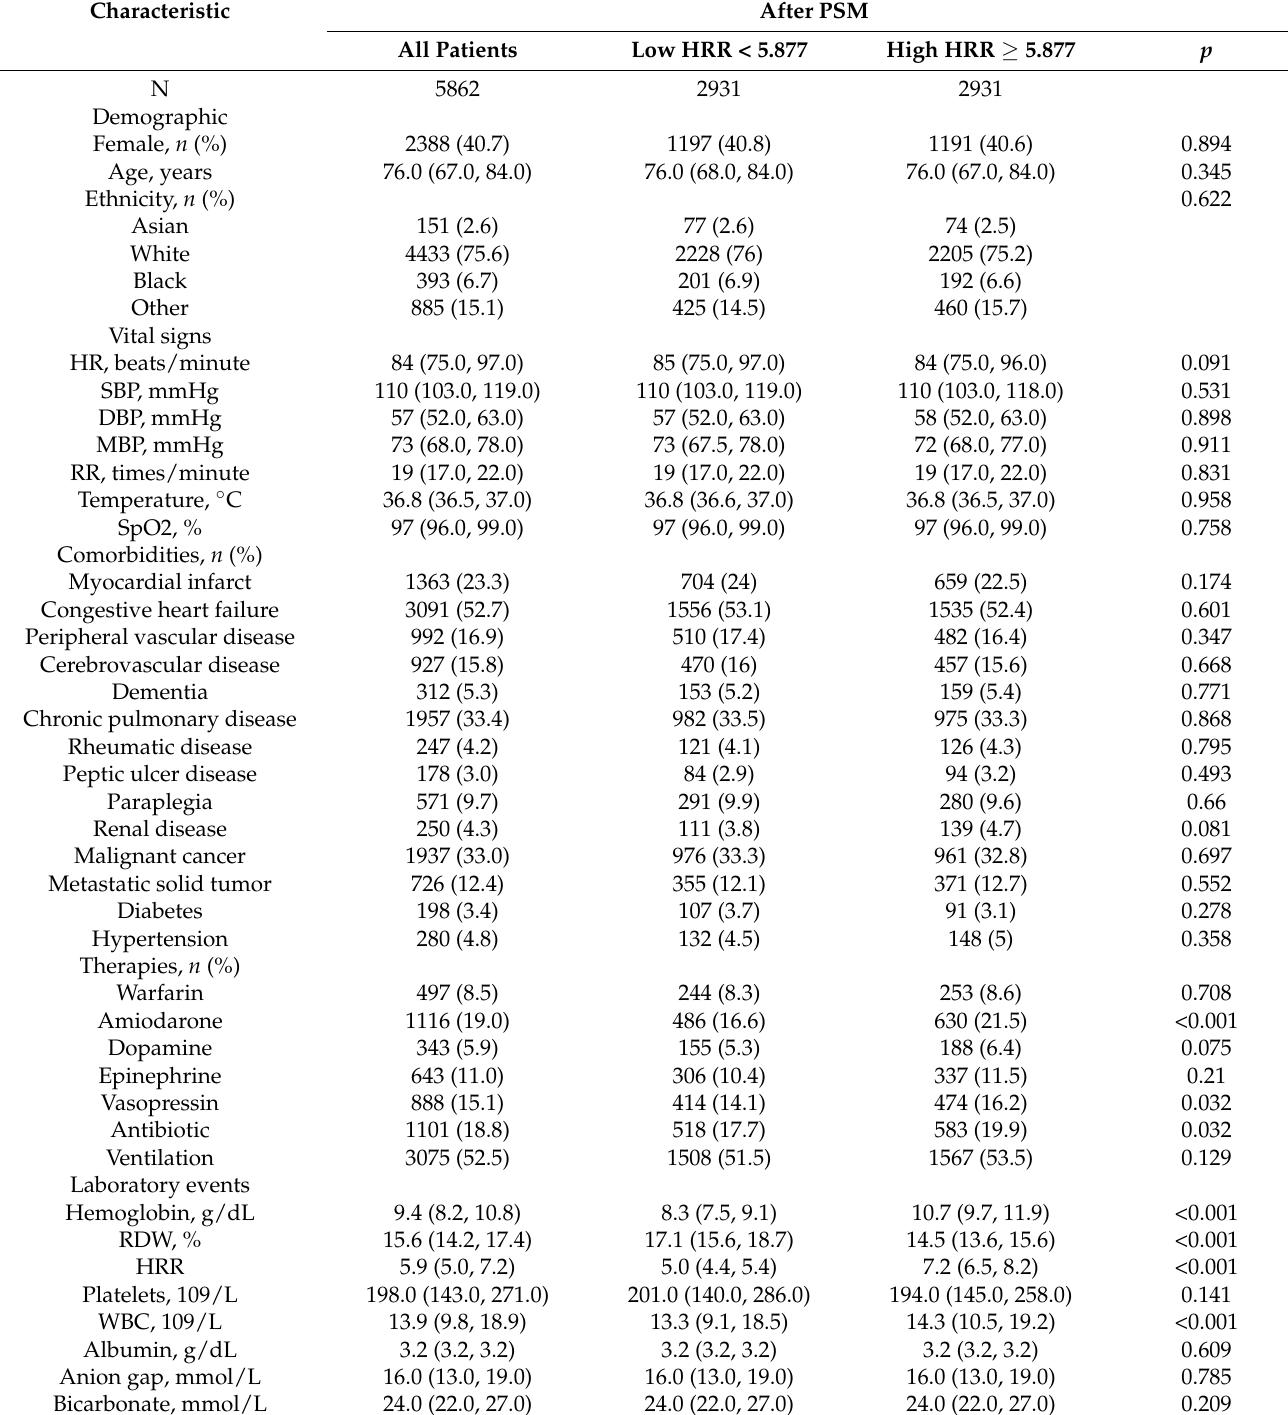
Table 4. The clinical characteristics of septic patients with atrial fibrillation after